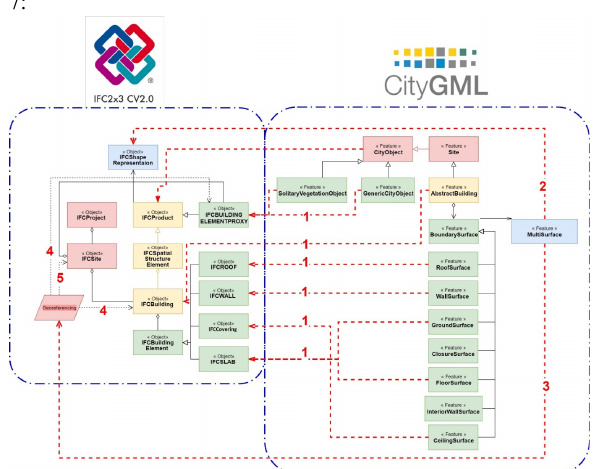
Figure 7. The complete methodology resulting data